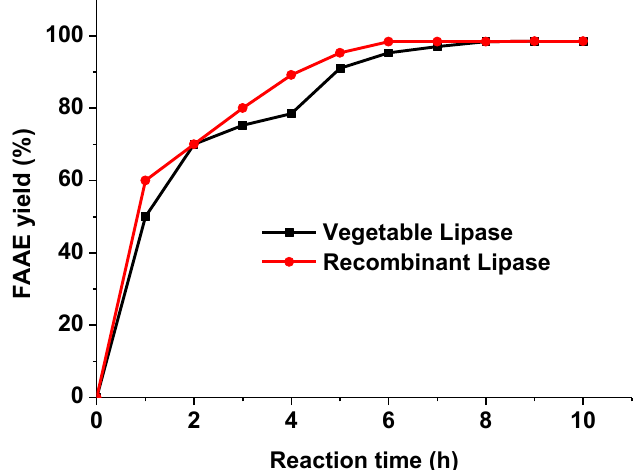
Figure 7. Effect of reaction time on the transesterification of crude Jatropha curcas L. oil. Reaction parameters: Jatropha curcas L. oil 10 g, ethanol to oil mass ratio 10, water content 9.1 wt%, immobilized lipase 5.25 g, mixing intensity 6 g RCF, temperature 35 °C, pH value 7.5.